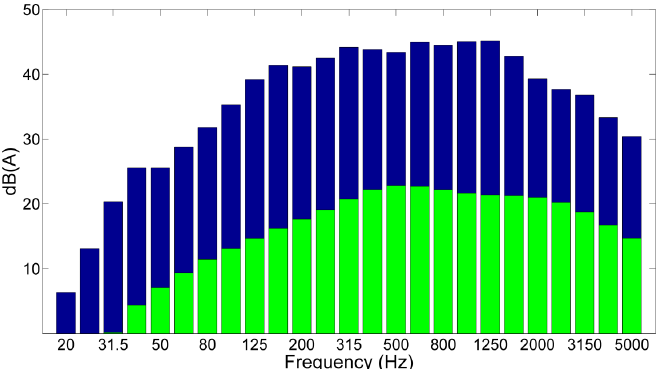
Figure 4. 1/3 octave band of T1-turbine sound pressure level: experimental ( blue ) and modeled ( green ). Both cases for a wind speed (hub height) of 8.0 m/s.